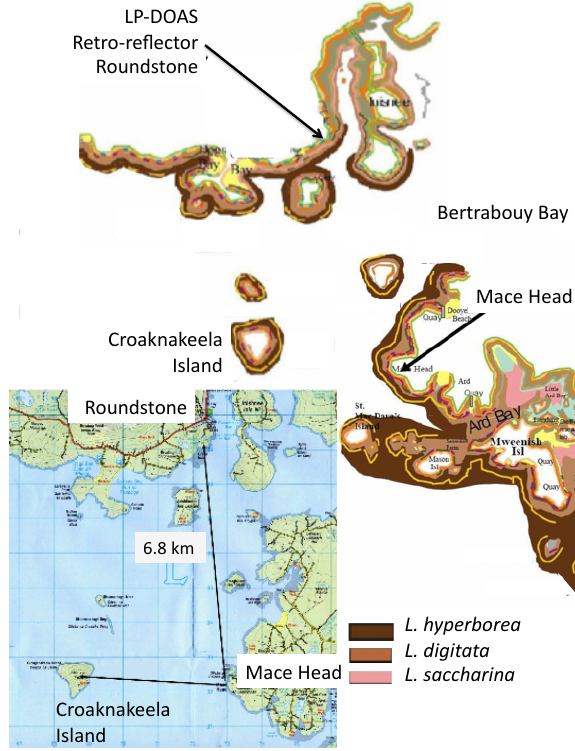
Fig. 1. Schematic representation of macroalgae location recorded during a 2000 survey. Extensive Laminaria beds were observed in the inter-tidal areas under the LP-DOAS light path. Adapted from Connemara Seaweed Survey 2001. Irish Seaweed Centre, NUIG Internal report 72 pp. (Bottom Left): ordinance Survey Map of Mace Head showing the 6.8km LP-DOAS light path between Mace Head and Roundstone to the north. Croagnakeela Island 4.2km to the west has been used as the location of the retro-reflector in previous